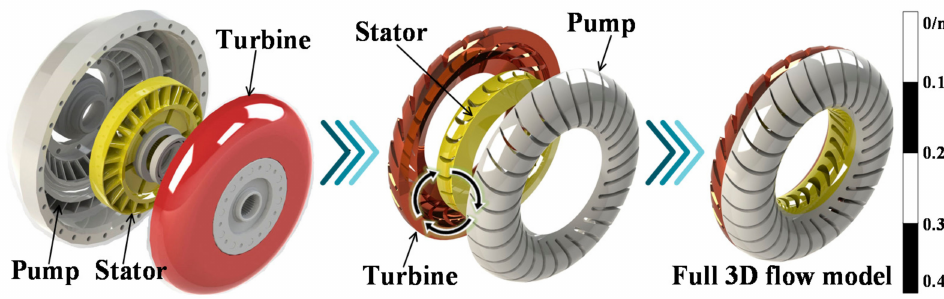
Figure 2. Full 3D flow model of the torque converter.